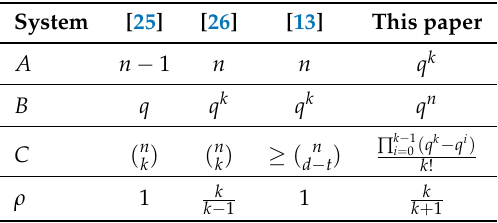
Table 1. Comparison with Other